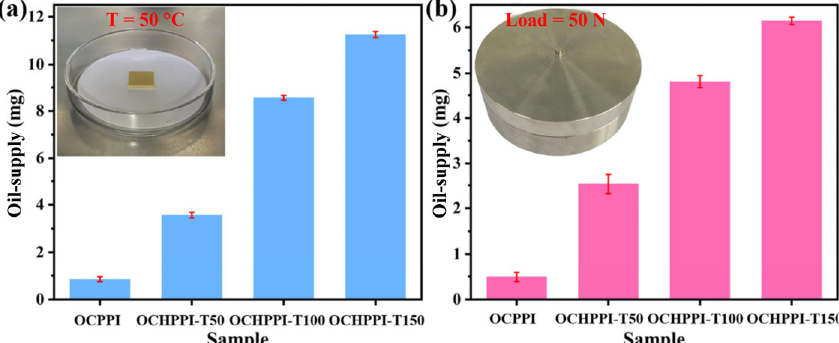
Fig. 9 Oil supply of different samples under (a) thermal-stimulus and (b) mechano-stimulus.